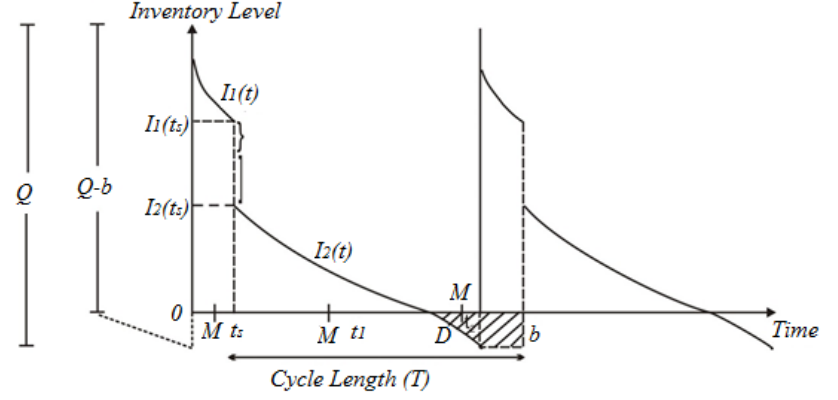
Fig. 2. Graphical representation of inventory system over time